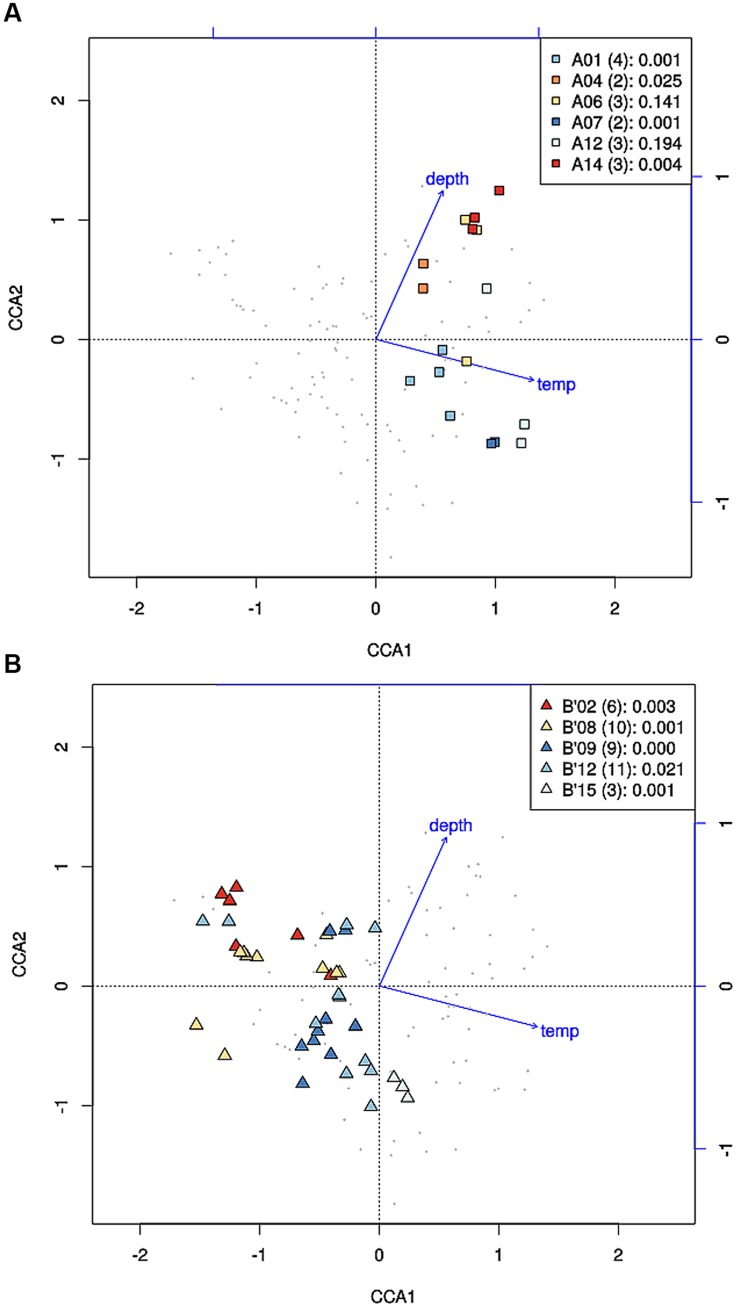
Canonical correspondence analyses of high-frequency psaA sequence variants predicted by Ecotype Simulation to belong to the same targeted putative ecotype (PE) for A-like (A) and B′-like (B)Synechococcus PEs. Small gray data points represent high-frequency sequence variants detected in analysis of six vertical profiles in replicate samples from 60, 63, and 65°C. High-frequency sequences that represent predominant PEs are color-highlighted as indicated by the inset together with the number of variants and the p-value associated with the cluster being different from random.